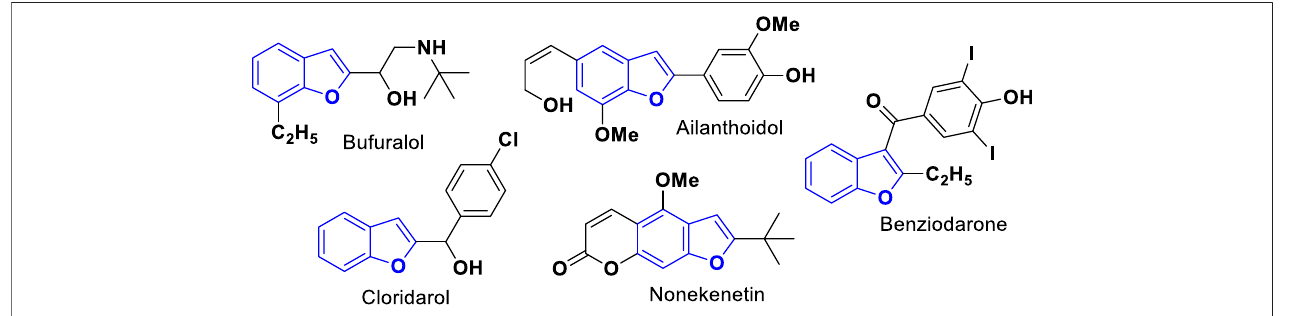
FIGURE 1 | Benzofuran containing some drug molecules.